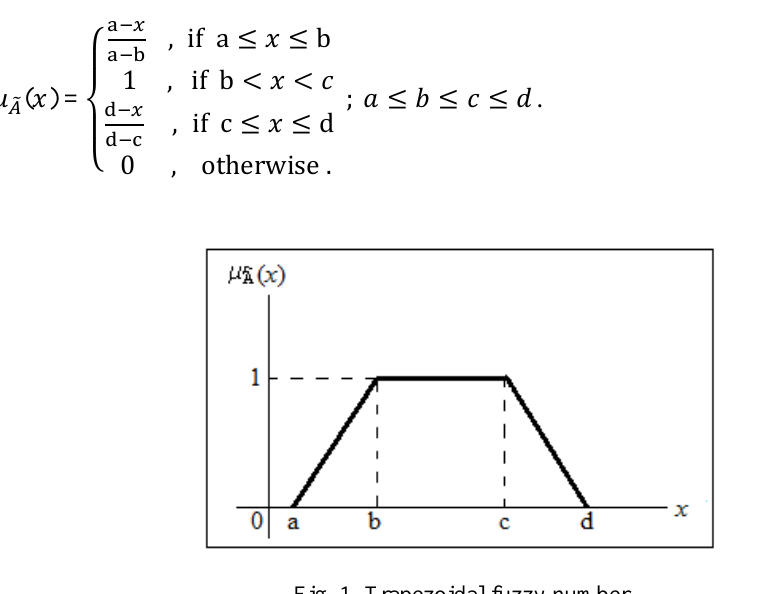
Fig. 1. Trapezoidal fuzzy